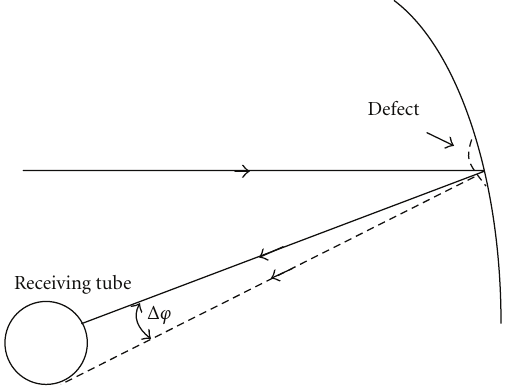
Figure 4: Rays deviation in the direction of the receiver tube.